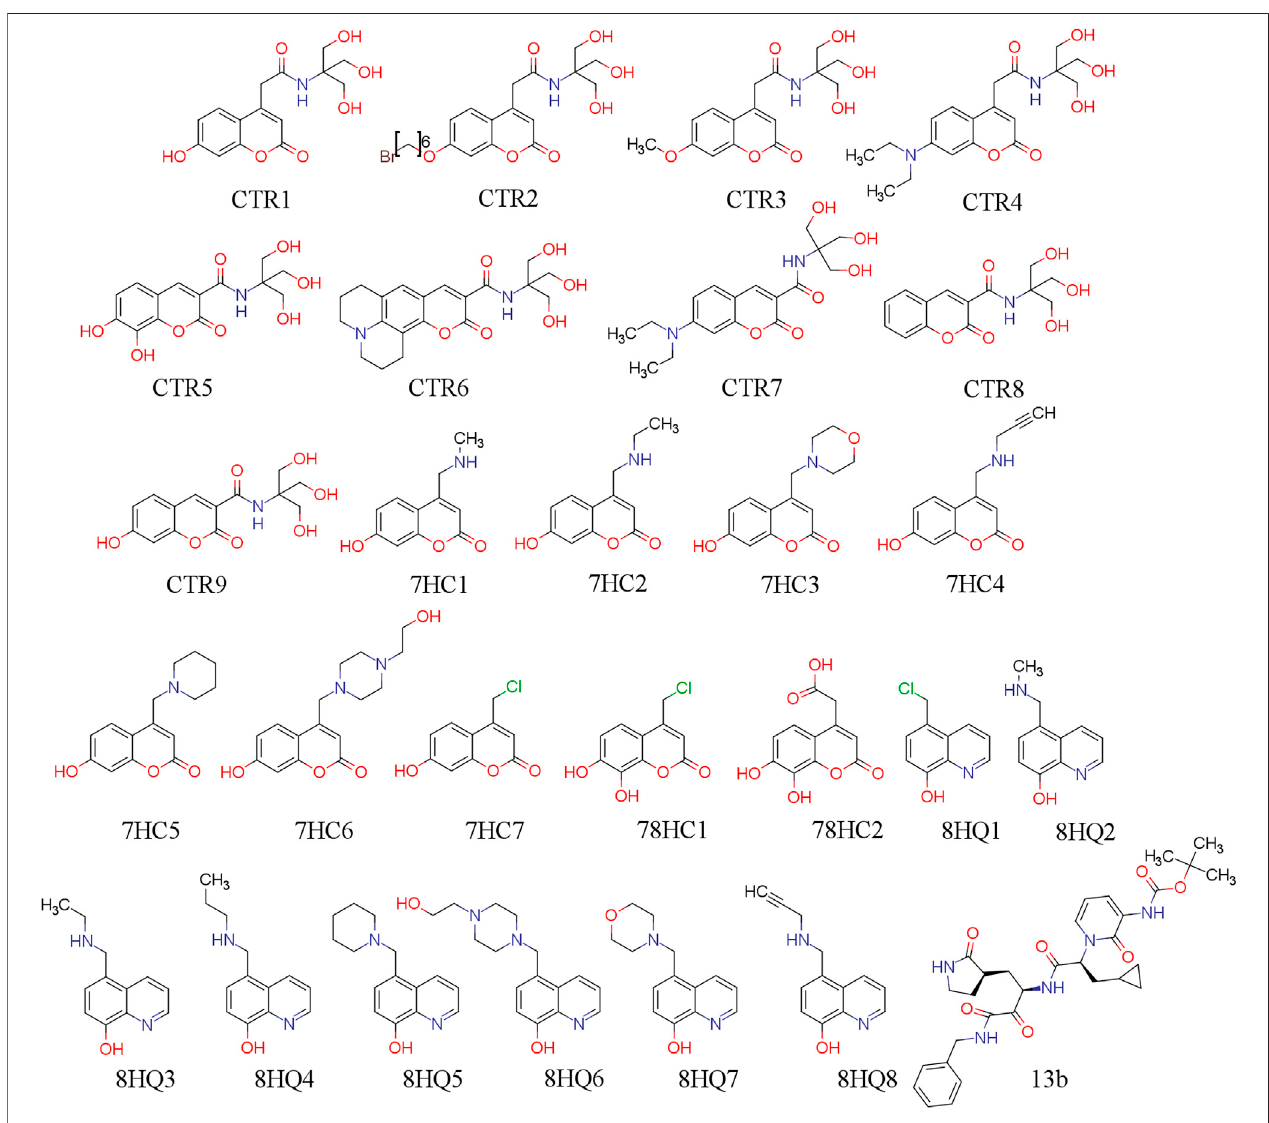
FIGURE 1 | 2D chemical structure of ligand under